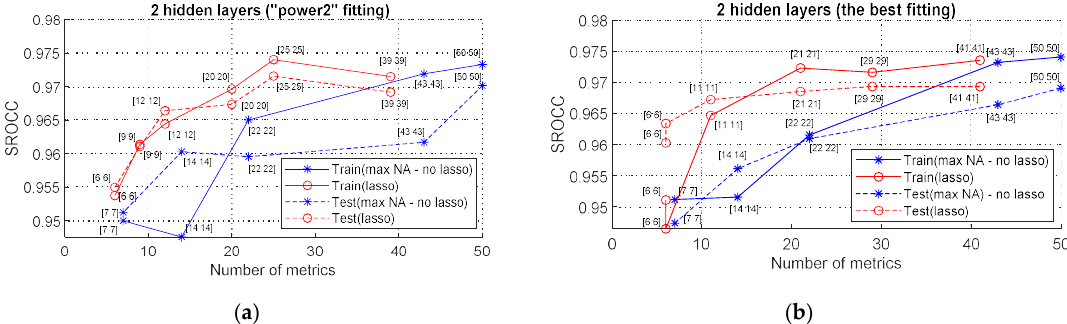
Figure 6. SROCC values for NNs with two hidden layers with different numbers of inputs and an equal number of neurons in hidden layers with two ways of fitting: ( a ) PFF; ( b ) the best fitting.